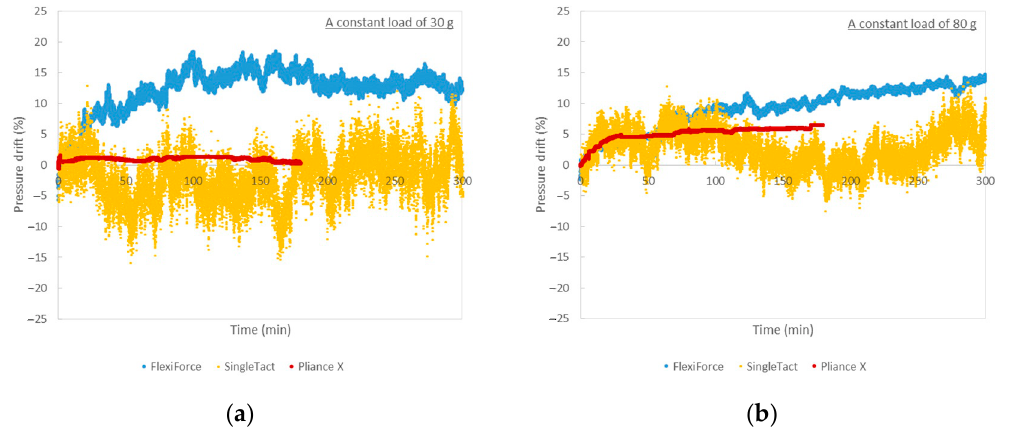
Figure 10. ( a ) Pressure drift of different sensors with time (applied load of 30 gf) and ( b ) Pressure drift of different sensors with time (with applied load of 80 gf).